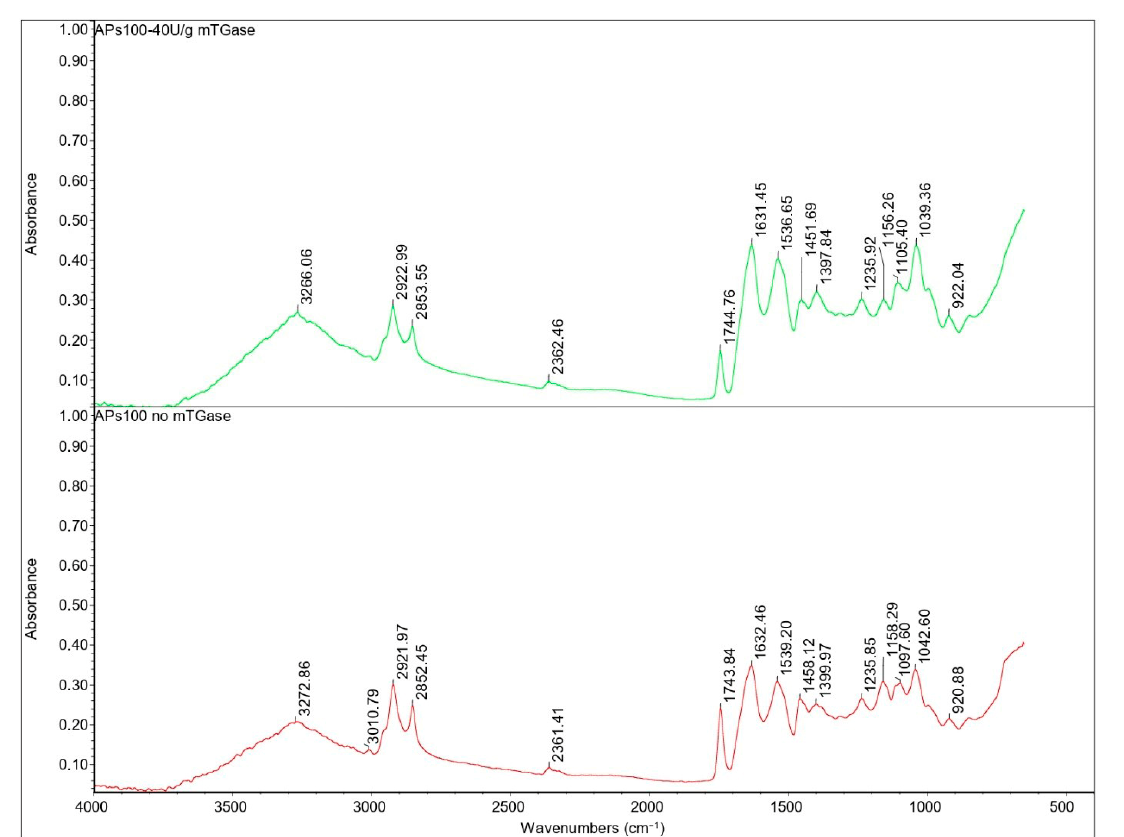
Figure 8. FT-IR spectra of APs100-based films in the presence and the absence of mTGase. The peak at 1745 cm − 1 is attributed to the stretching vibration of ester carbonyl C=O functional groups of the triglycerides present in APs. The area of the spectrum between 1480–1200 cm − 1 is the fingerprint area of proteins, which was attributed to single bond (C-H and N-H) vibration and tautomerism of the amide structure [32]. The absorption bands at 1630 and 1540 cm − 1 represent amides I and II,